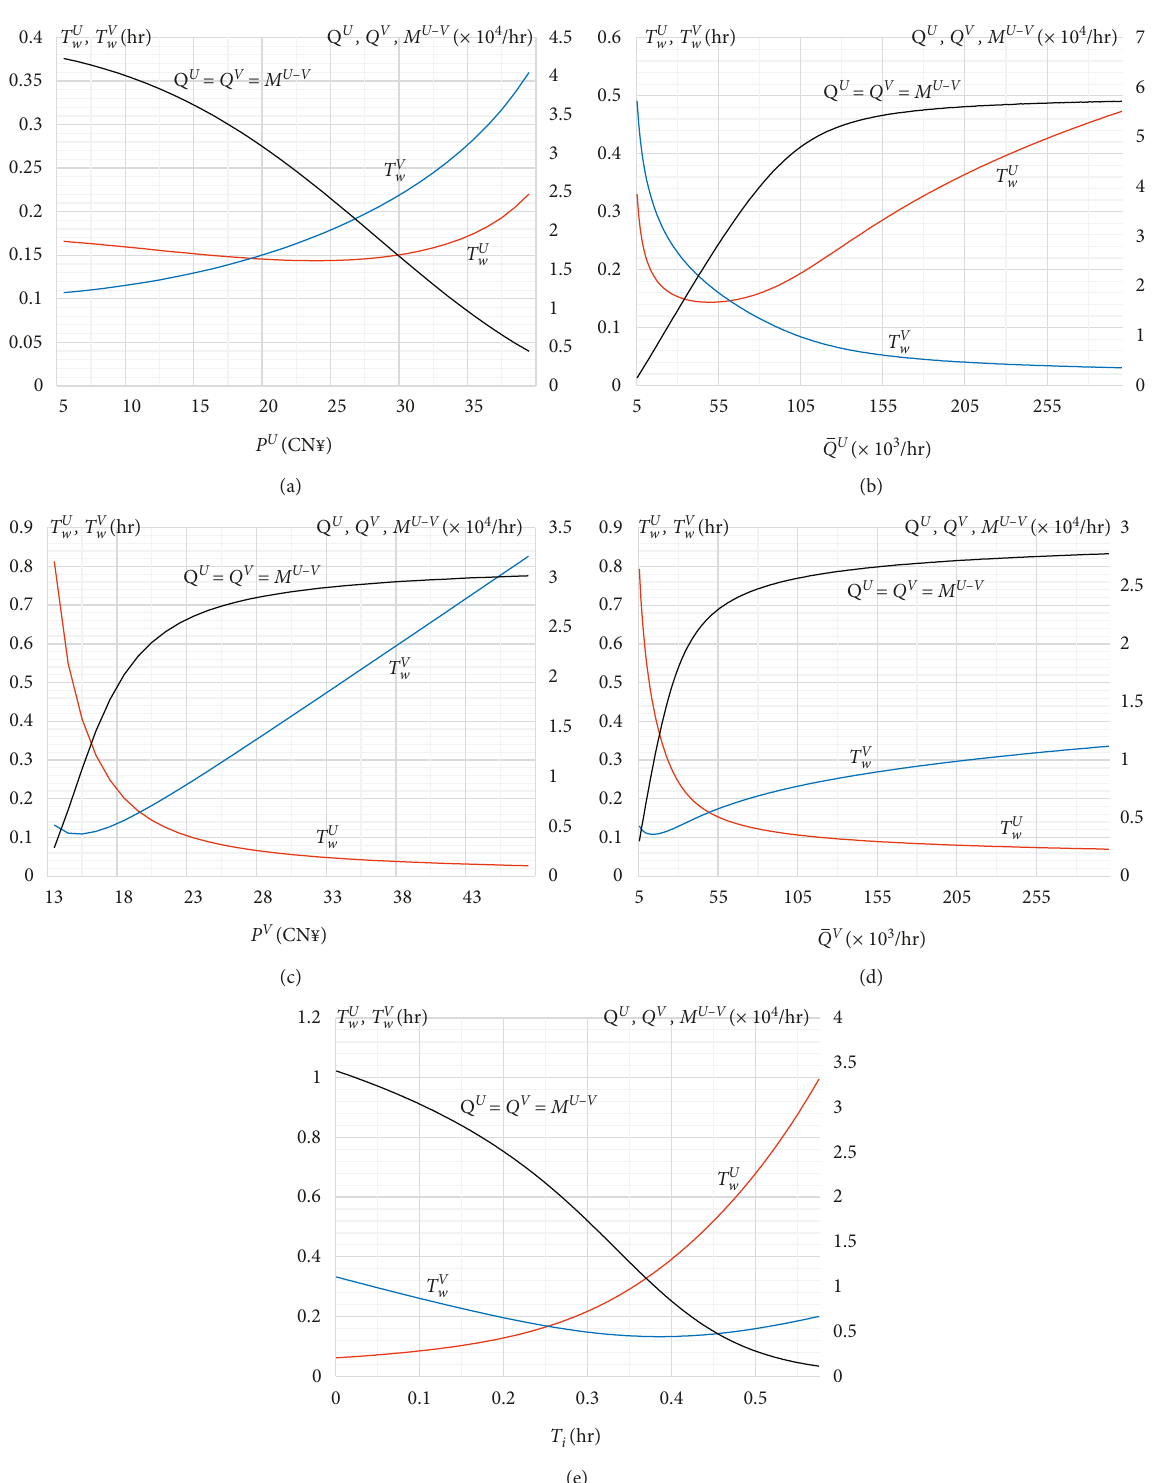
Figure 3: Equilibrium transitions. (a) Passenger fare changes. (b) Potential demand changes. (c) Driver wage changes. (d) Potential supply changes. (e) In-vehicle time